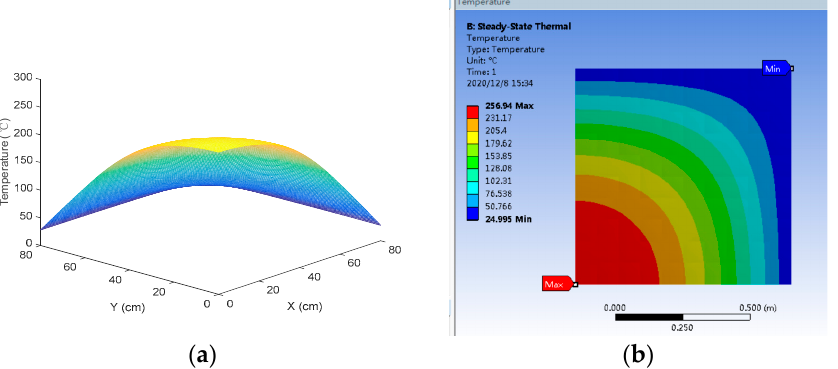
Figure 9. Heat transfer calculation results for the steady-state problem of non-uniform internal heat source (( a ) FEMN solution, and ( b ) analytical solution).